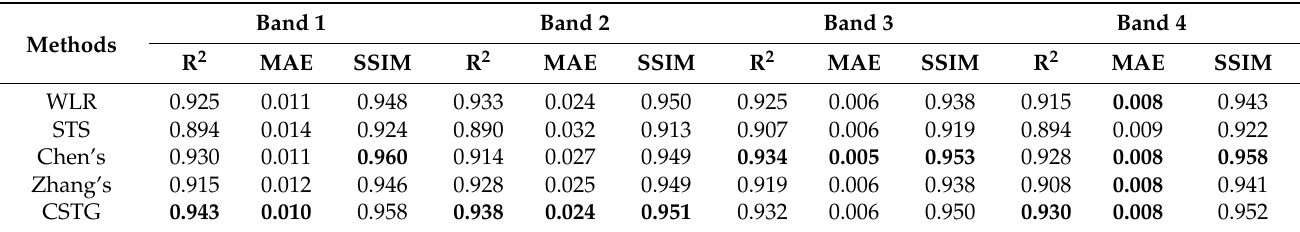
Table 2. The evaluation metrics for four individual bands in the masked areas between the original images obtained from MOD09A1 and the images recovered using different methods. Small and dispersive masks were applied to the original images. The values in bold are the best values for each metric.